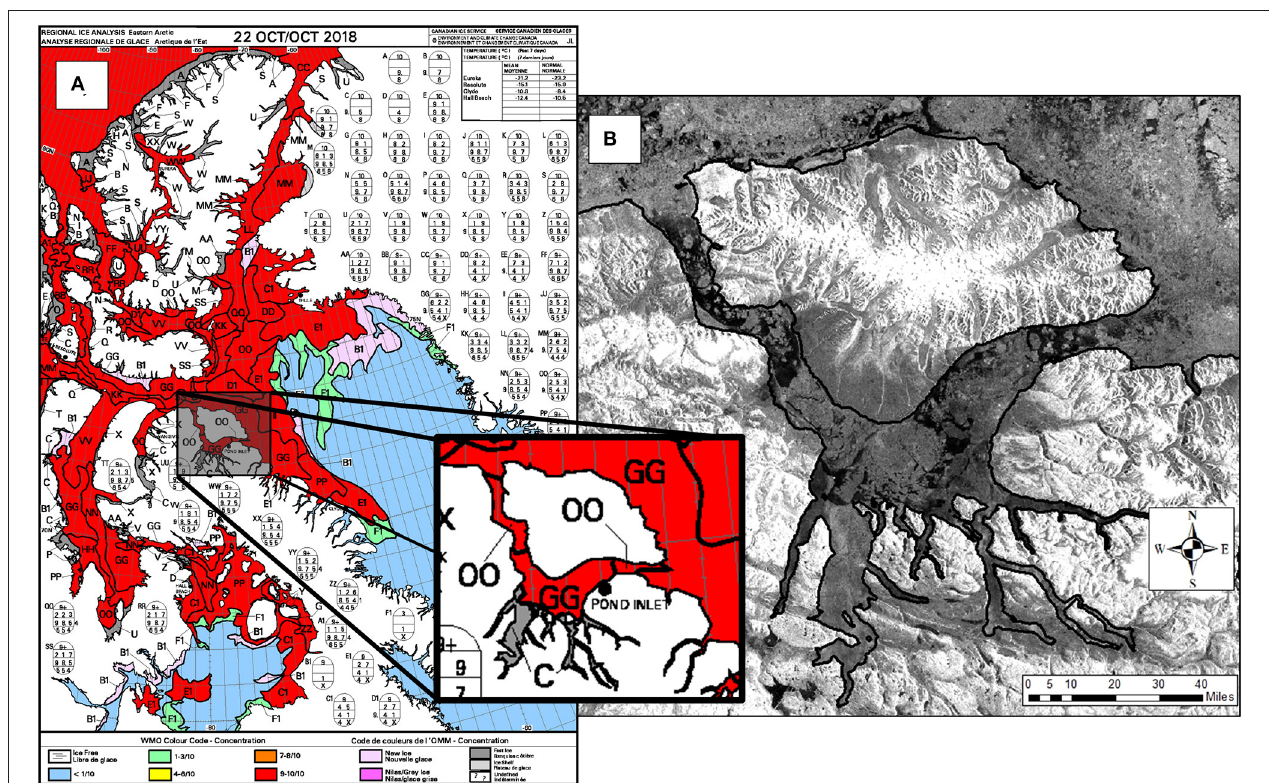
FIGURE 4 | (A) CIS eastern Arctic regional ice chart for October 22, 2018 (ECCC, 2020); (B) RADARSAT-2 ScanSAR Wide image of the Mittimatalik region, October 22, 2018 (CSA, 2019).